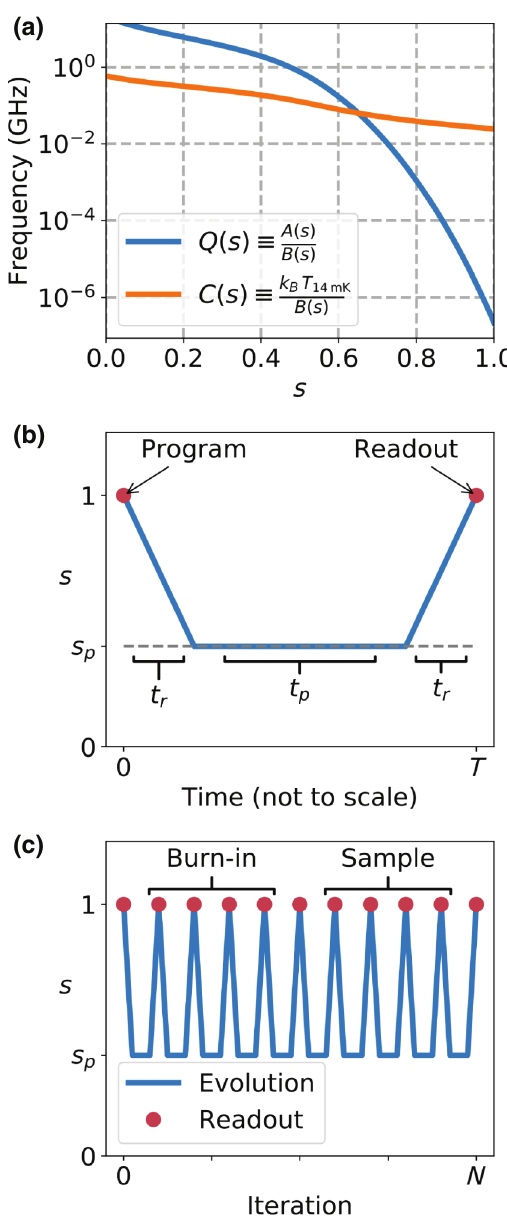
FIG. 6. (a) The annealing parameter s controls amplitudes A ( s ) and B ( s ) in the device Hamiltonian, Eq. (2). Here Q ( s ) quanti- fies the relative strengths of these terms as a function of s . Also shown is the dependence on s of the ratio to amplitude B ( s ) and the characteristic thermal energy of the system at the operat- ing temperature of 14 mK. (b) A single QEMC anneal schedule that shows the initialization of the annealer with an eigenstate of the classical Hamiltonian [ A ( s ) (cid:7) B ( s ) ] at t = 0, reverse anneal- ing for time t r , pausing for time t p at s p [where Q ( s ) ≥ 1], and forward annealing for time t r . (c) An iterative protocol where multiple QEMC steps are chained together by reprogramming the next QEMC step with the output from the previous QEMC step. The first half of the samples are discarded as burn-in steps while the chain equilibrates and the last half of the samples are collected and used for